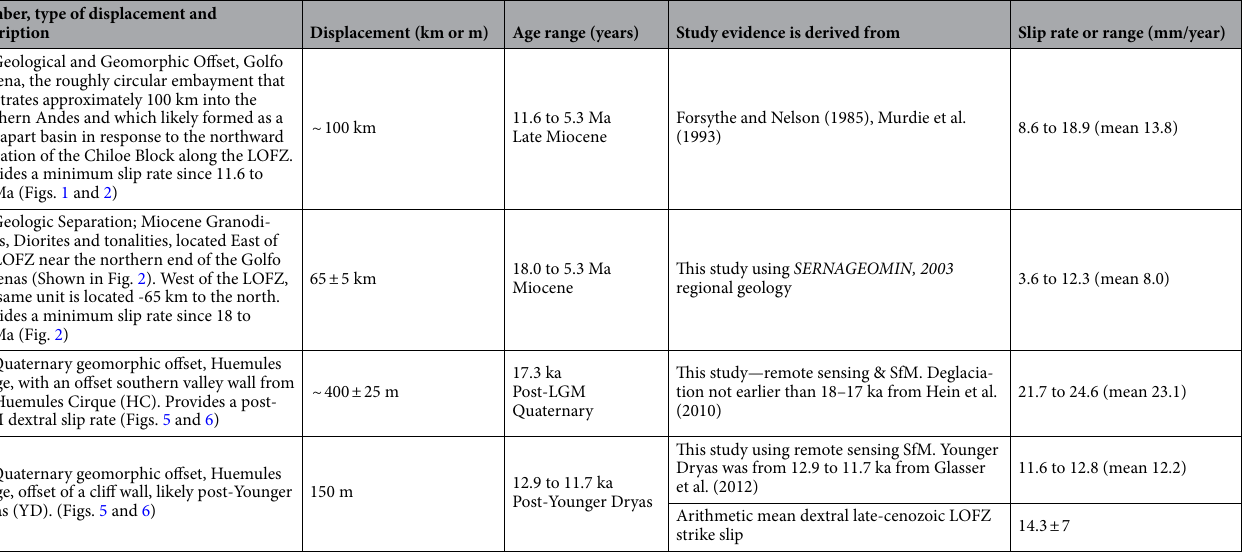
Table 1. Late-Cenozoic to present LOFZ geological seperation and displacement evidence with associated dextral, strike slip, slip